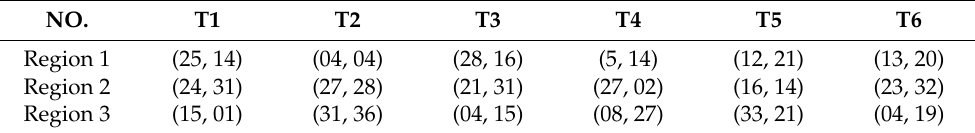
Table 5. The shrunken column and row number locations of the selected random regions.